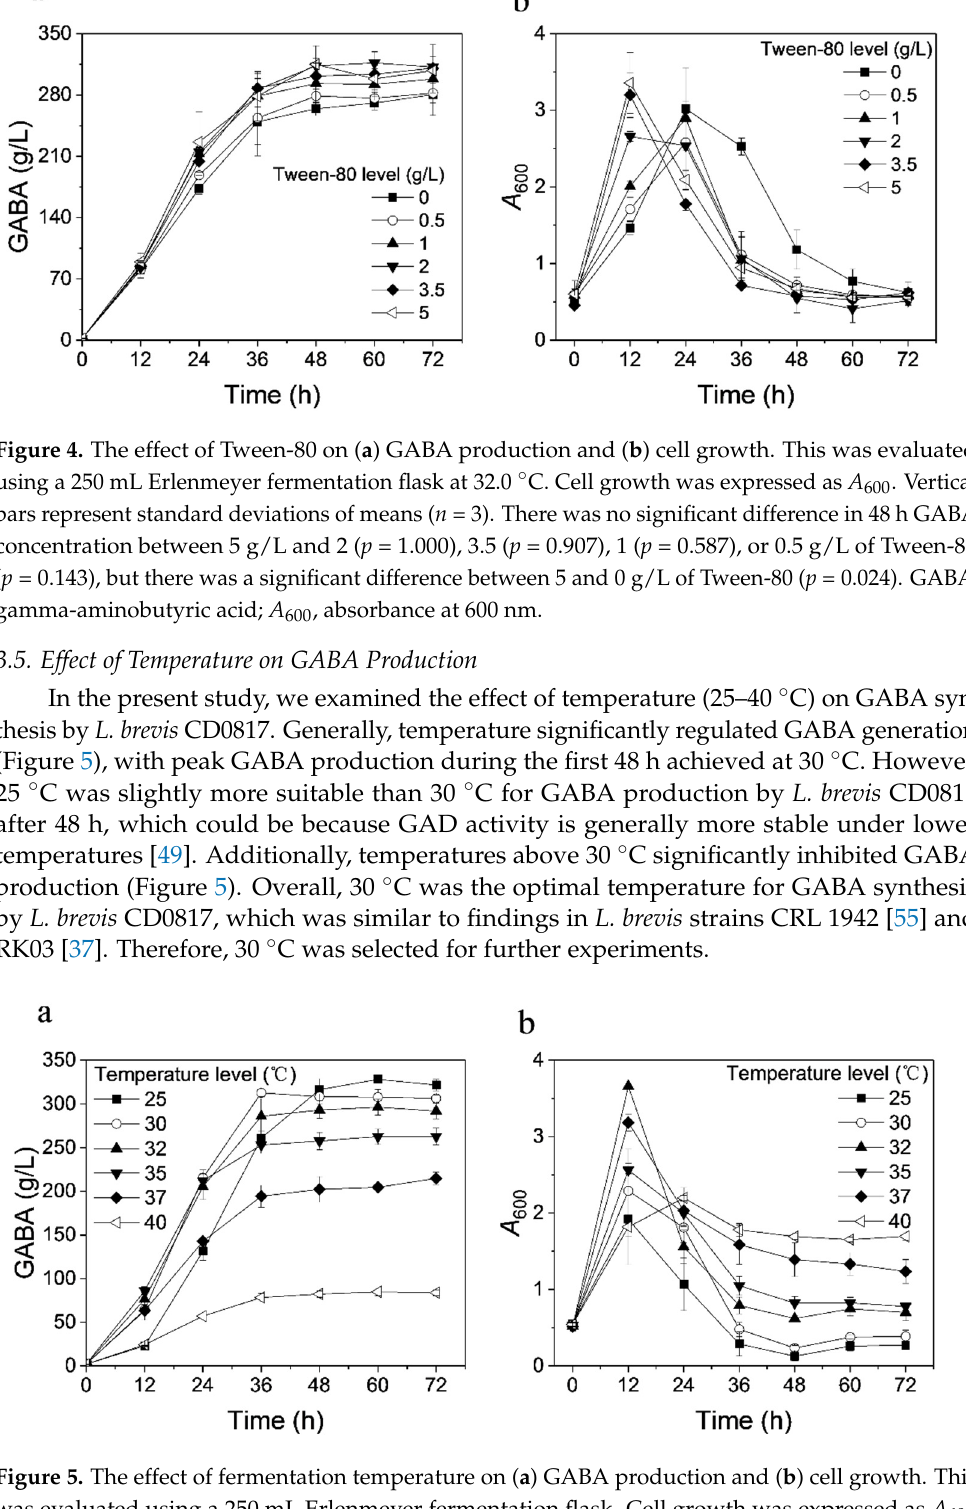
GABA concentration between 5 g/L and 2 ( p = 1.000), 3.5 ( p = 0.907), 1 ( p = 0.587), or 0.5 g/L of Tween- 80 ( p = 0.143), but there was a significant difference between 5 and 0 g/L of Tween-80 ( p = 0.024). GABA, gamma-aminobutyric acid; A 600 , absorbance at 600 nm.